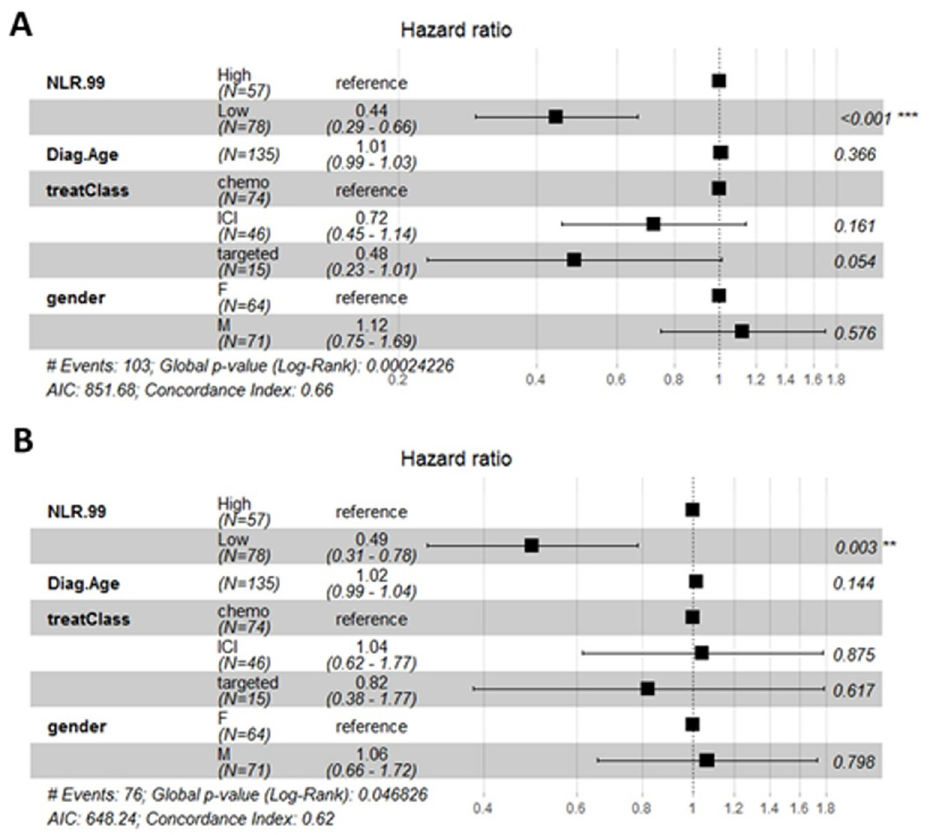
Fig 3. Forest plots to summarize the results of multivariate Cox Proportional Hazards models for NLR. Model results for PFS (A) and OS (B) shown. The model included NLR classification (Low/High), age at diagnosis (Diag.Age), type of treatment (treatClass; chemotherapy (chemo), ICI (immune checkpoint inhibitors), targeted agent (i.e. erlotinib)), and gender. The global model p-value is located under the plot, and p-values for variables are listed to the